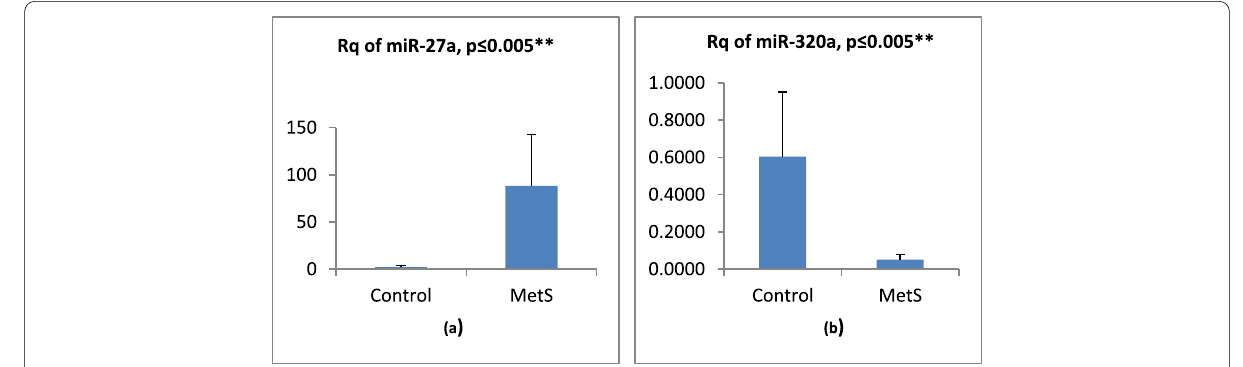
Table 2 Characteristics for ROC curve analysis of miR‑27a and miR‑320a